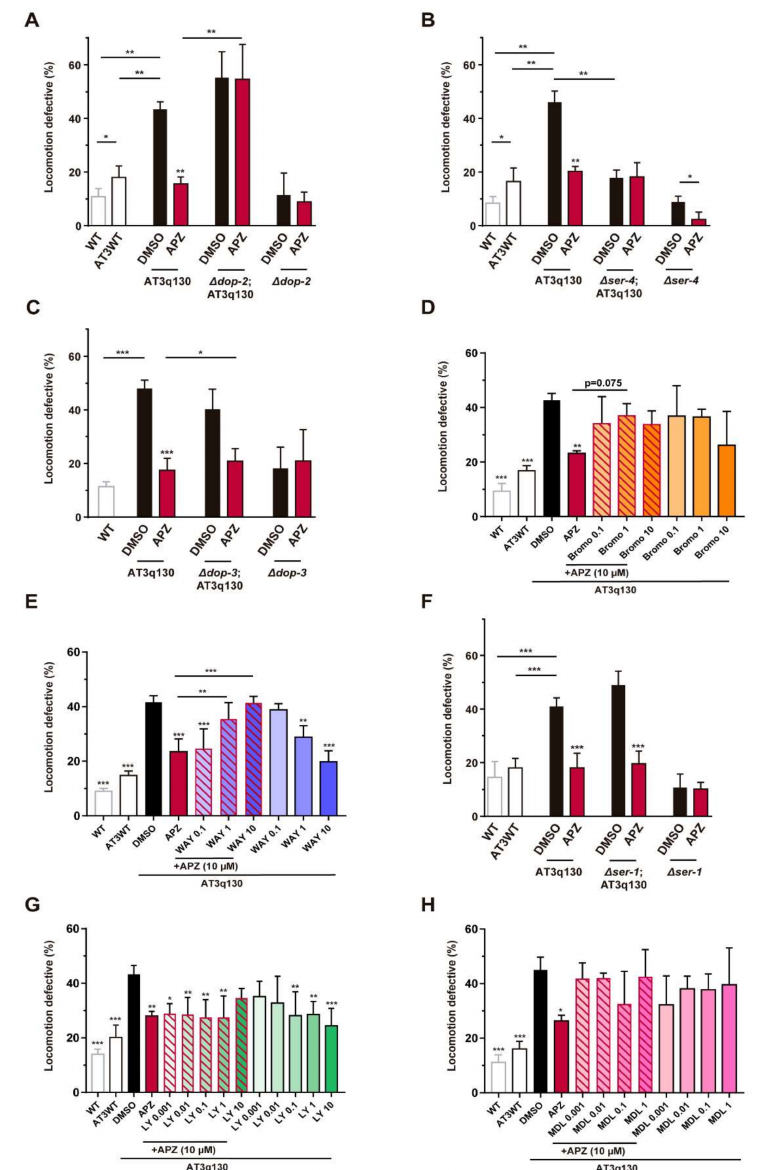
Figure 4. Pharmacogenetic and pharmacological approaches identify DOP-2 DRD2 , SER-4 5-HT1AR and SER-1 5HT2AR as the classic target receptors for the therapeutic effect of aripiprazole in MJD. Aripiprazole (10 µ M) treatment of C. elegans null strains for ( A ) dop-2 , ( B ) ser-4 , ( C ) dop-3 and co- treatment of aripiprazole with ( D ) bromopride (DRD 2 antagonist) and ( E ) WAY-100635 (5-HT 1A antagonist) showed that DOP-2 DRD2 and SER-4 5-HT1A are absolutely necessary for aripiprazole- mediated improvement of AT3q130 animals motor phenotype. DOP-3 DRD2 contributes partially to this effect. Ablation of ( F ) ser-1 had no impact on aripiprazole’s therapeutic effect, ( G ) aripiprazole and increasing concentrations of LY-266097 co-treatment improved AT3q130 animals’ motor defects, whereas ( H ) co-treatment of AT3q130 animals with aripiprazole and the inverse agonist MDL-100907 precluded the action of aripiprazole. This suggests that the antagonism of SER-1 5-HT2A is important to aripiprazole’s therapeutic effect. Statistics: A, B ( n = 4, ± SD), * p < 0.05, ** p < 0.01 (Factorial ANOVA, followed by a Sidak test corrected for BCA for multiple comparisons). C, F ( n = 4, ± SD), * p < 0.05, *** p < 0.001 (Factorial ANOVA, followed by a Sidak test for multiple comparisons). D ( n = 4, ± SD), ** p < 0.01, *** p < 0.001 (One-way ANOVA followed by a Games-Howell Post-Hoc for multiple comparisons and One-way ANOVA Post-Hoc Tukey). E, G, H ( n = 3 − 4, ± SD), * p < 0.05, ** p < 0.01, *** p < 0.001 (One-way ANOVA followed by Dunnett Post-Hoc for multiple comparisons and One-way